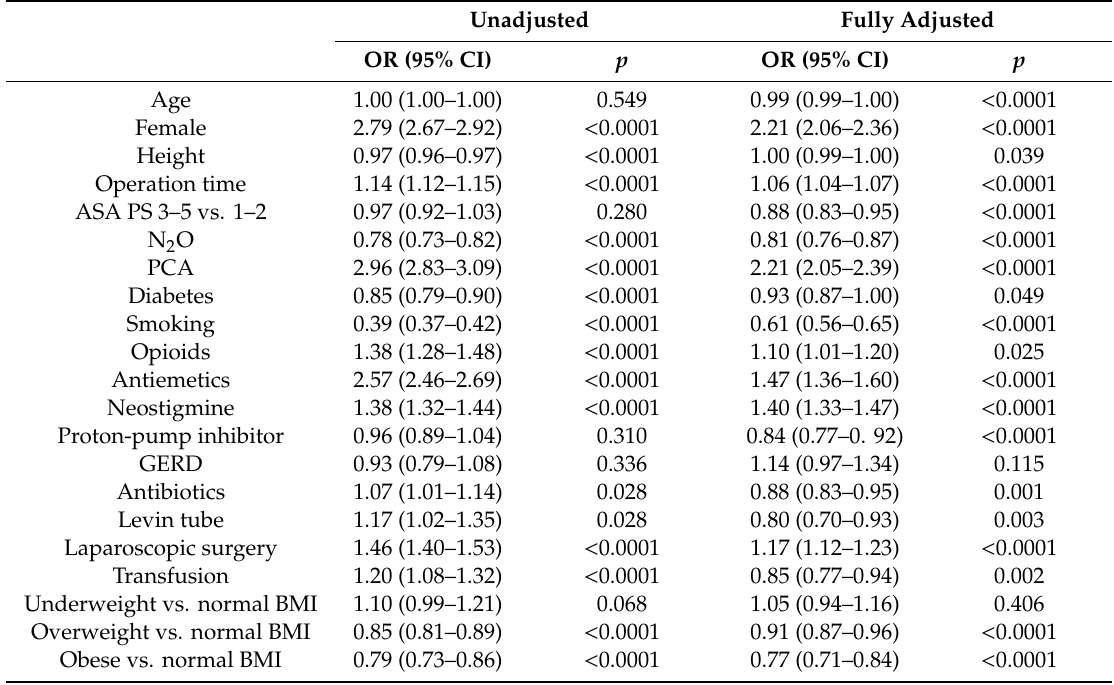
Table 2. Unadjusted and fully adjusted odds ratios (ORs) of each variable for postoperative nausea and vomiting.